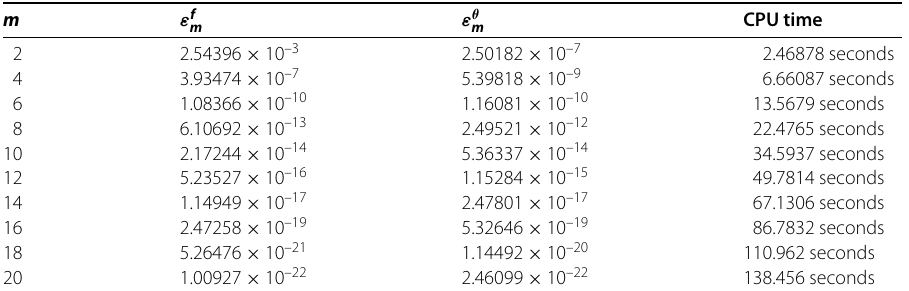
Table 2 Individual averaged squared residual errors using optimal values of auxiliary parameters